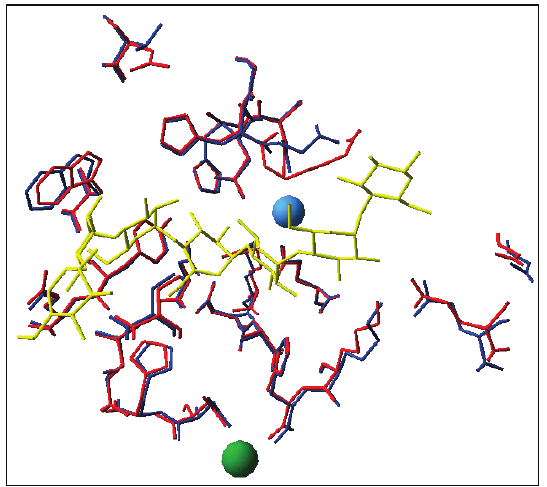
F 6: Structure of the active site. Superimposition of the active site residues in psychrophilic (blue) and mesophilic (red). e chloride and calcium ions are shown as blue and green spheres, respectively. e 24 residues performing direct or water- mediated interactions with a substrate analog (yellow) are identical and superimpose almost perfectly within the resolution of the struc- tures, demonstrating a structural identity in these psychrophilic and mesophilic enzymes